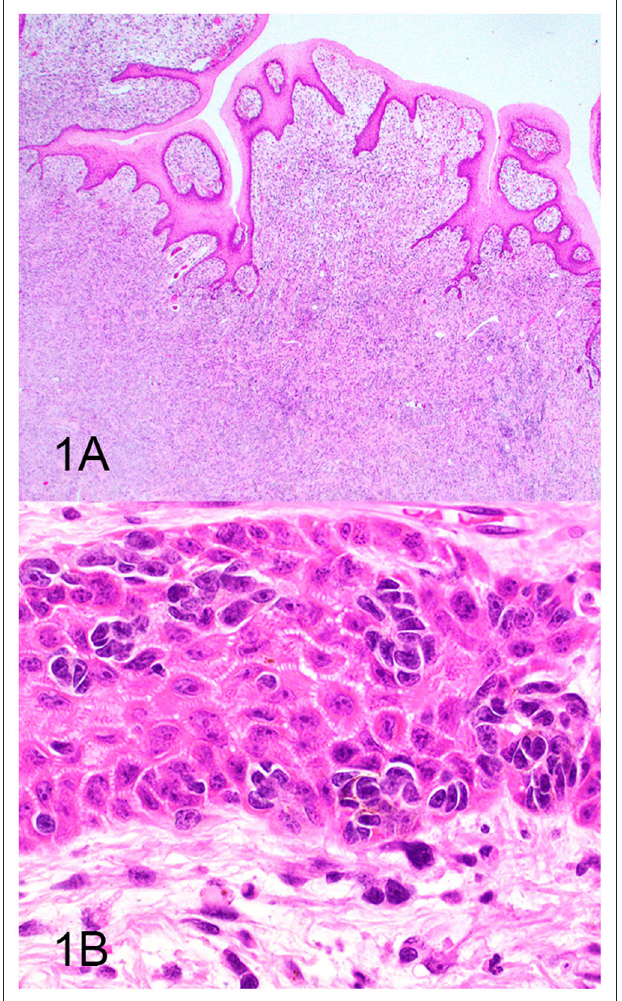
FIGURE 2 | Soft tissue sarcoma (STS), hematoxylin and eosin staining. (A) STS composed of sheets of spindloid cells. Magnification, × 4. (B) Higher magnification of (A) highlighting spindle cells arranged in a fingerprint pattern. Magnification, ×